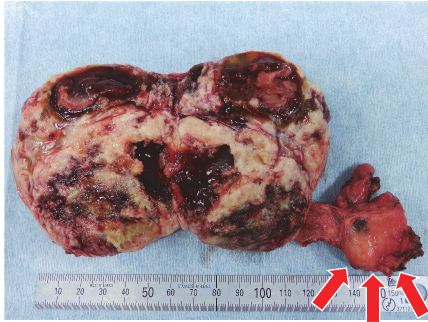
Figure 4: Macroscopic finding of resected prostatic tumor. Red arrow: prostate.